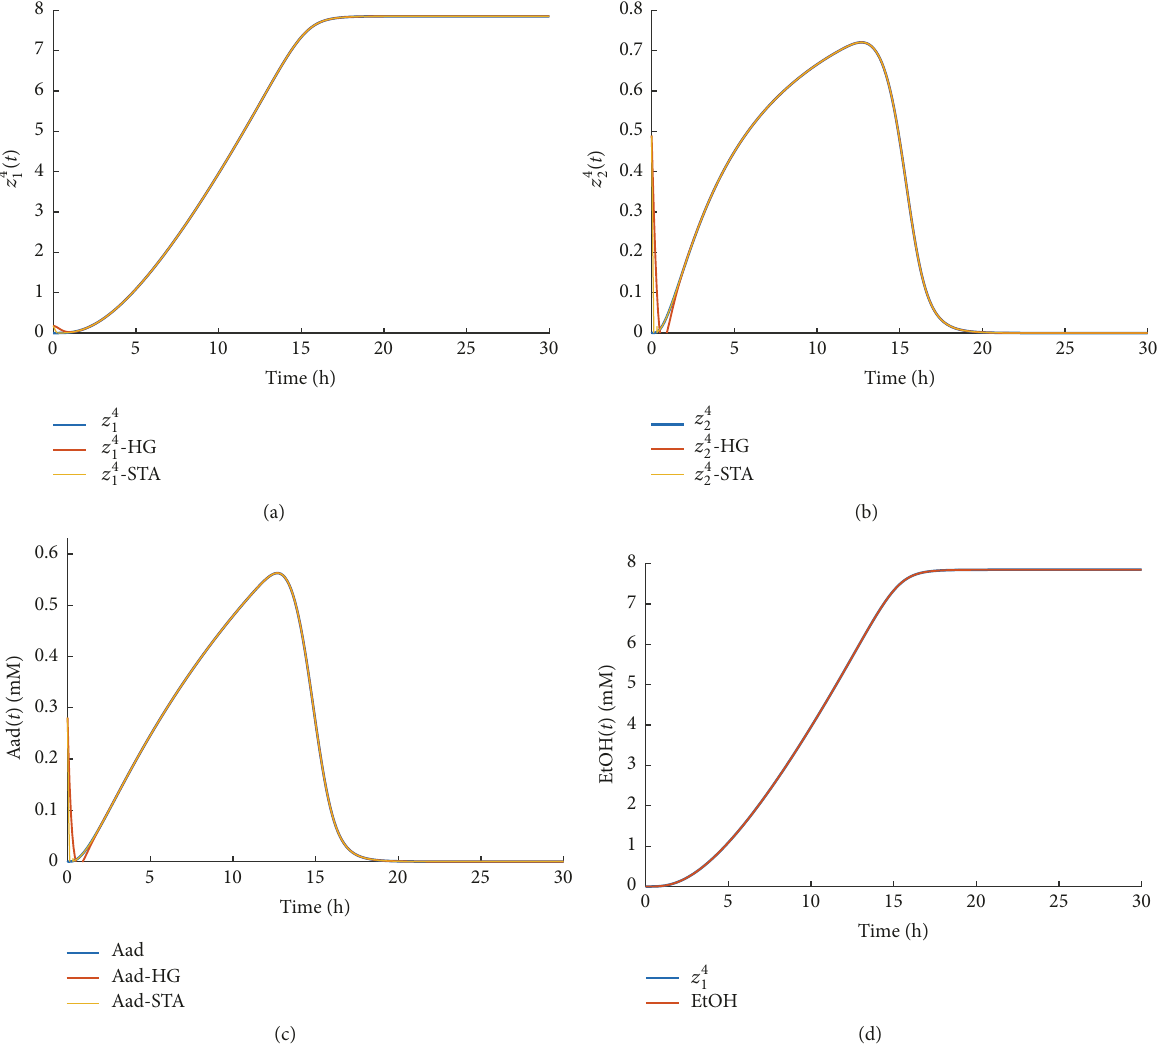
Figure 4: Simultaneous visualization for the states of the transformed coordinates in the third subsystem, the corresponding high-gain observer, and the STA-based estimator: (a) 𝑧 4 1 and (b) 𝑧 4 2 . (c) and (d) depict the variation of the concentrations for the compounds (c) Aad and (d) EtOH as well as their estimates produced by the inverse transformation applied to both the high-gain and the STA-based observer.